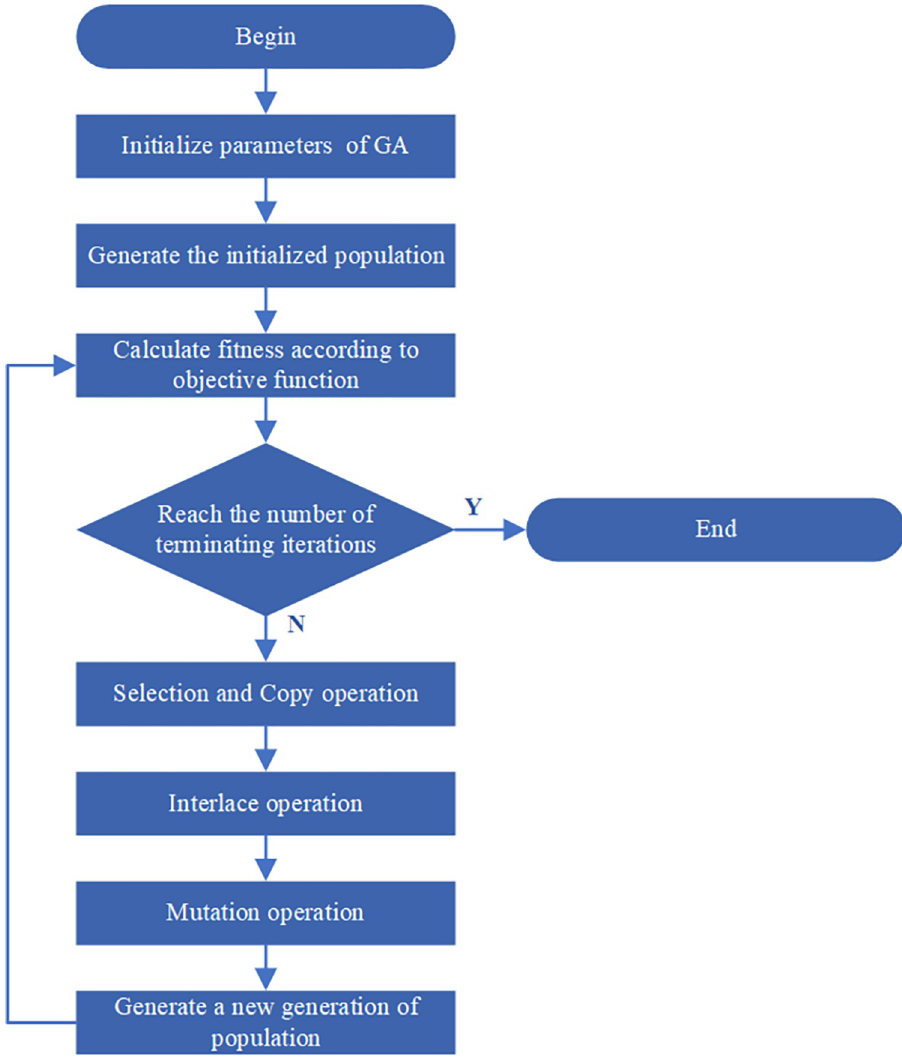
Fig 8. The realisation process of genetic